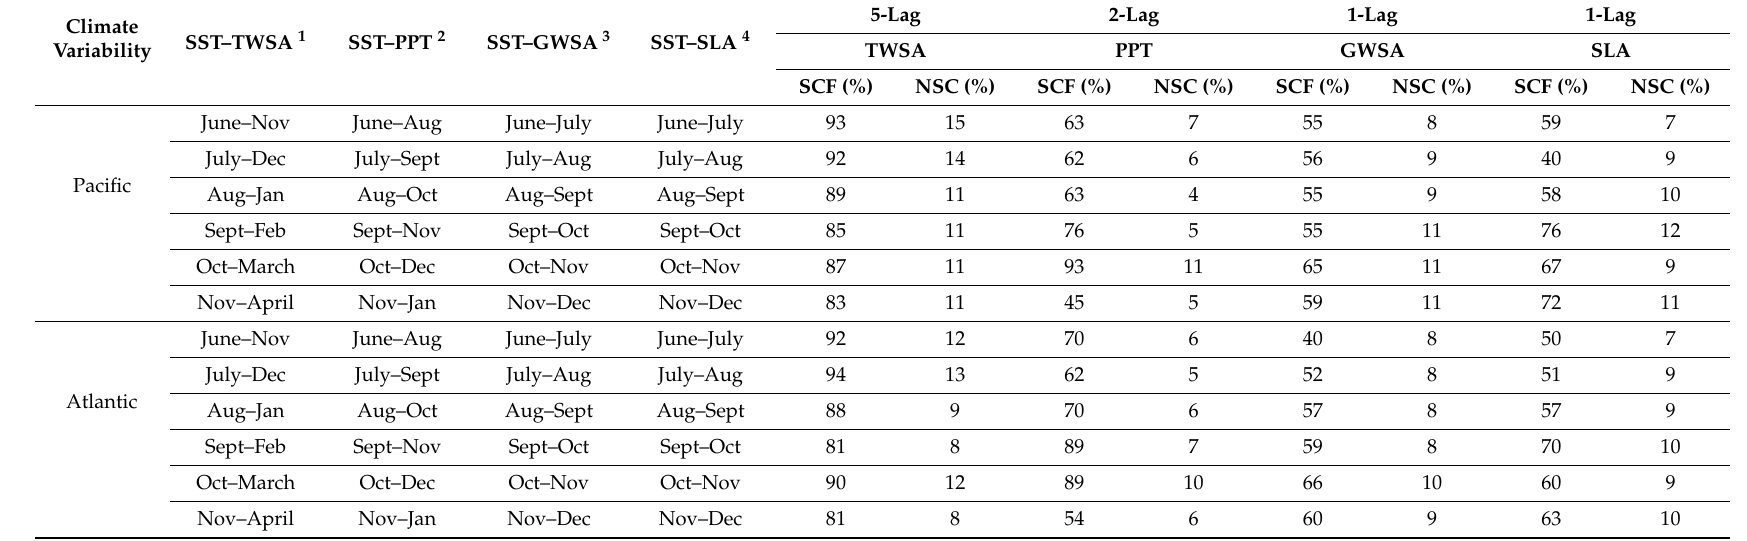
Table 2. Squared Covariance Fraction (SCF) and Normalized Squared Covariance (NSC) values corresponding to the SST relationship with Terrestrial Water Storage Anomaly (TWSA), GWSA, Sea Level Anomaly (SLA), and precipitation (PPT) (in %) of the Pacific and Atlantic Ocean for the HUC-03 region. Climate